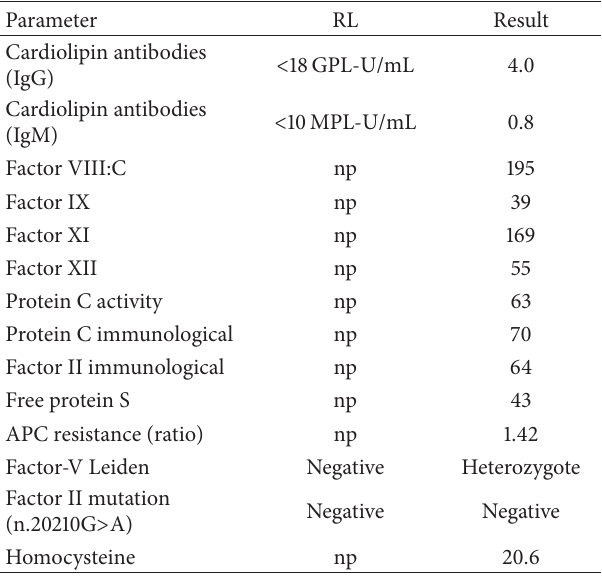
Table 2: Coagulation